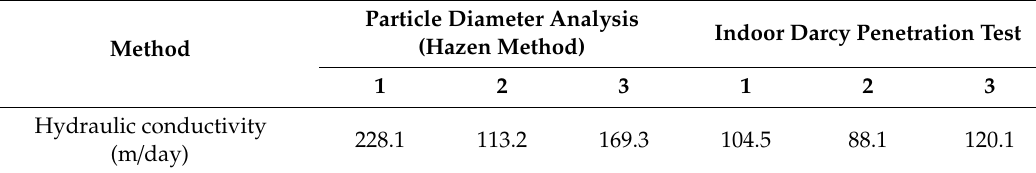
Table 1. Hydraulic conductivity of unconfined aquifer in riparian